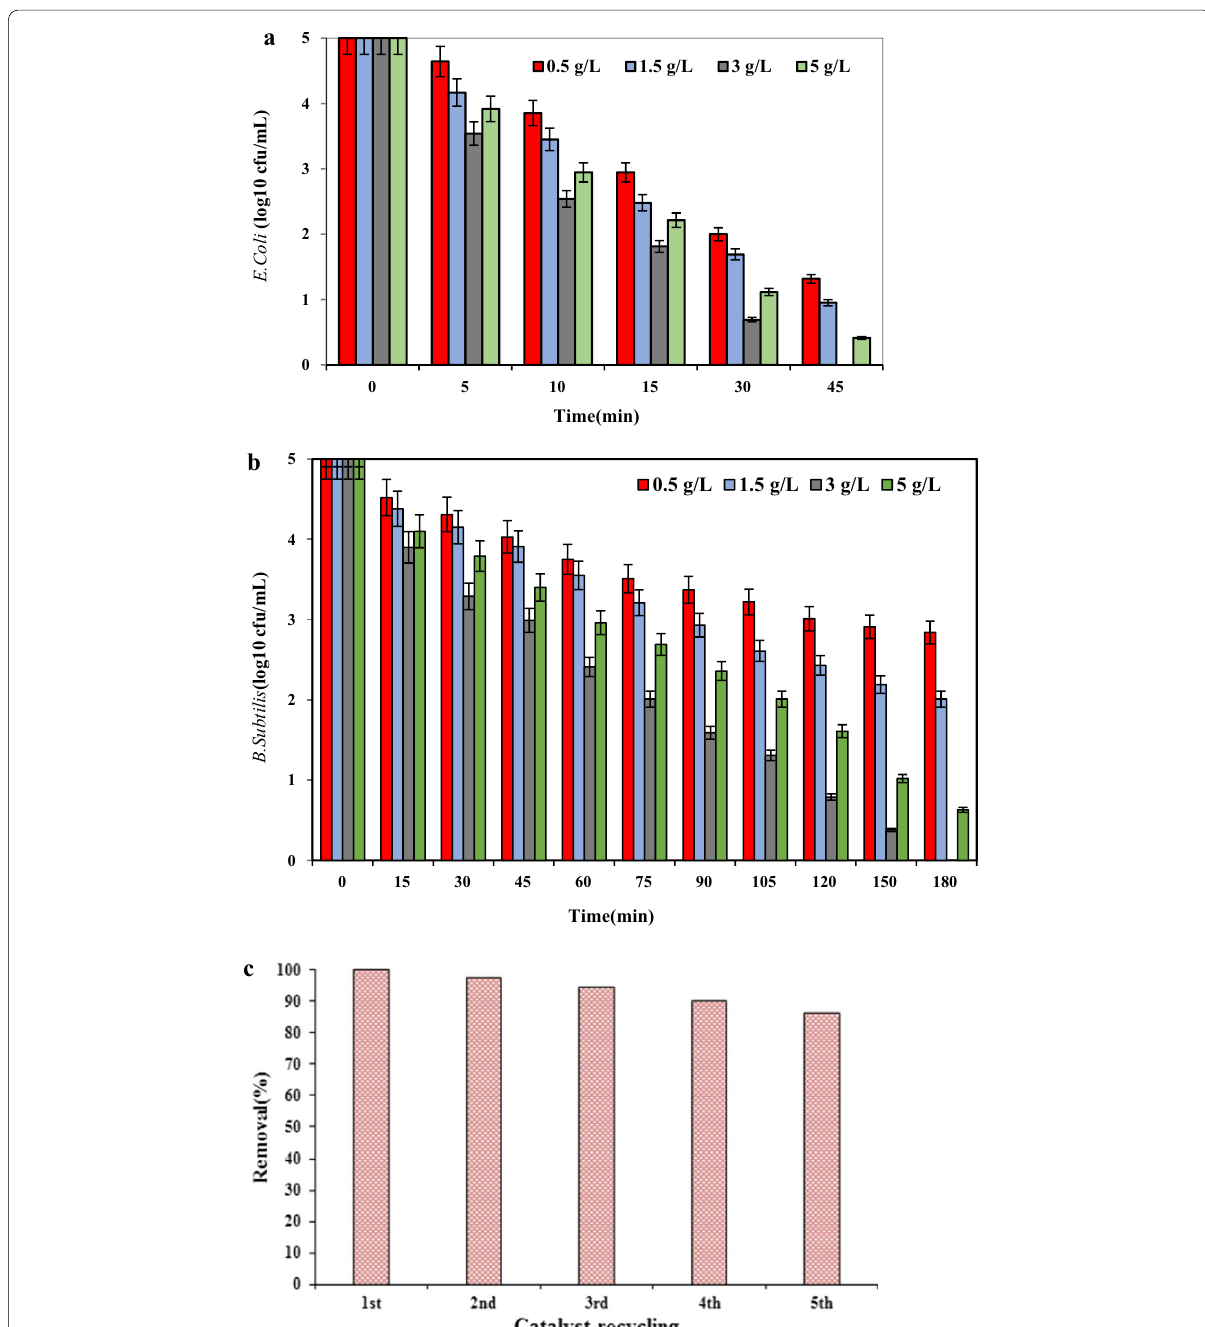
Fig. 3 a Effect of catalyst dosage on E. coli inactivation rate, b Effect of catalyst dosage on B. subtilis inactivation rate, c bacterial inactivation efficiency for 3–5 repeated experiments using recycled